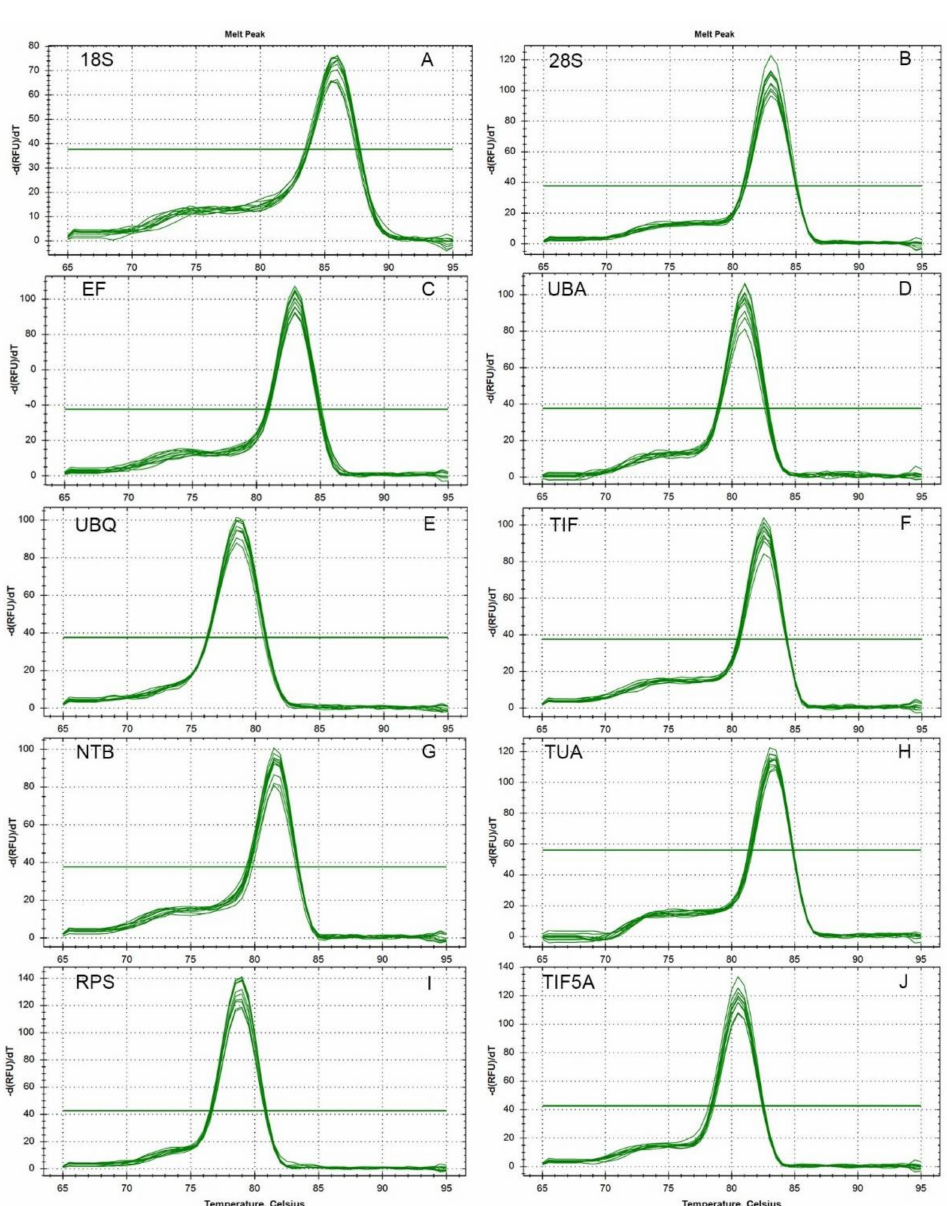
Figure 2. Melt curves of the 10 reference genes, 18S , 28S , EF , UBA , UBQ , TIF , NTB , TUA , RPS , and TIF5A